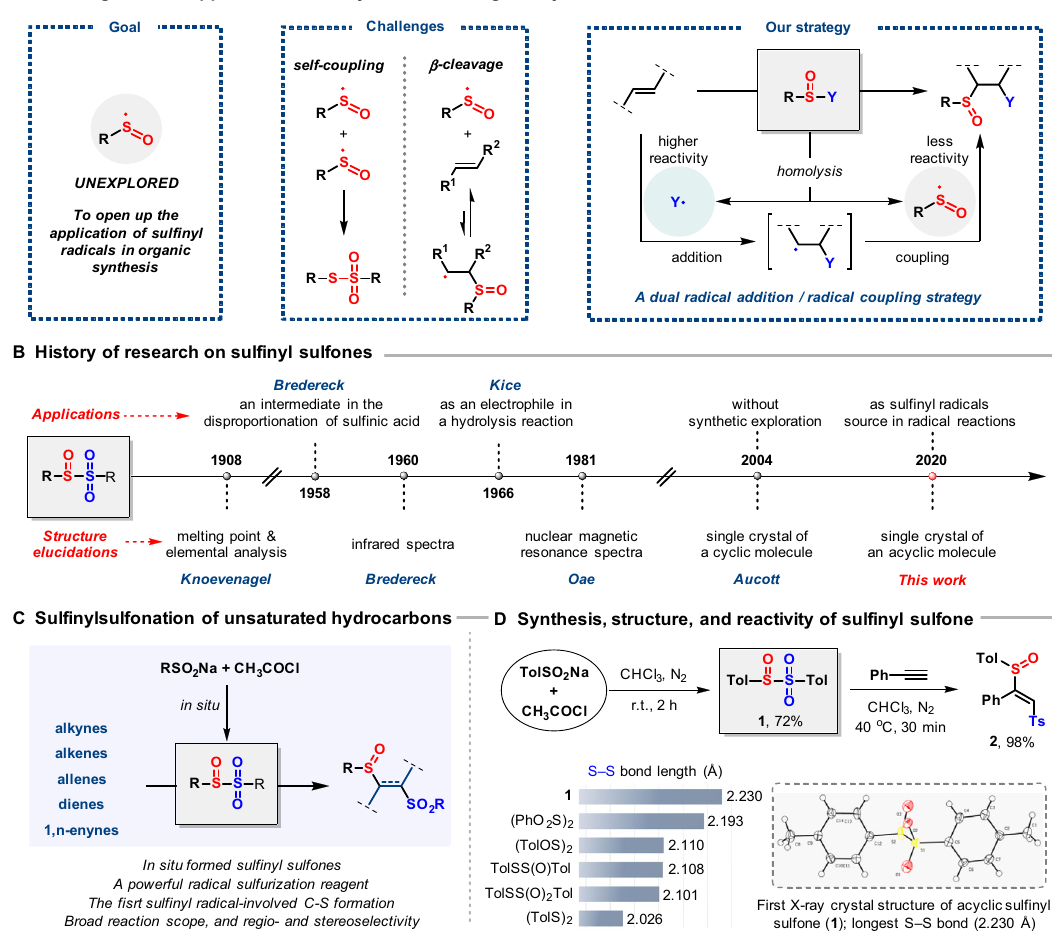
Fig. 1 The research history of sul fi nyl sulfones and their application as a precursor of sul fi nyl radical. A Design of a strategy for the application of sul fi nyl radicals in organic synthesis; B the discovery history of sul fi nyl sulfones, with emphasis on the limited synthetic access and applications; C sul fi nylsulfonation of various unsaturated hydrocarbons with in situ formed sul fi nyl sulfones; D The synthesis, single-crystal X-ray structure of sul fi nyl sulfone 1 , comparison of the S – S bond length (Å) with that of other analogous compounds, and the sul fi nylsulfonation of